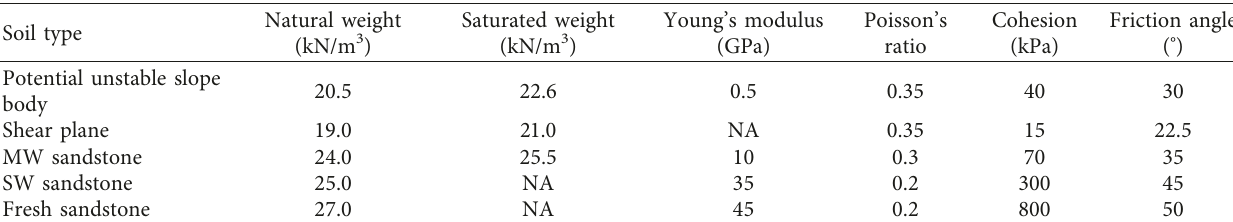
Figure 4: Longitudinal section of the studied slope (MW, moderately weathered sandstone; SW, slightly weathered sandstone; WT, water table). Table 2: Physical and mechanical properties of relevant